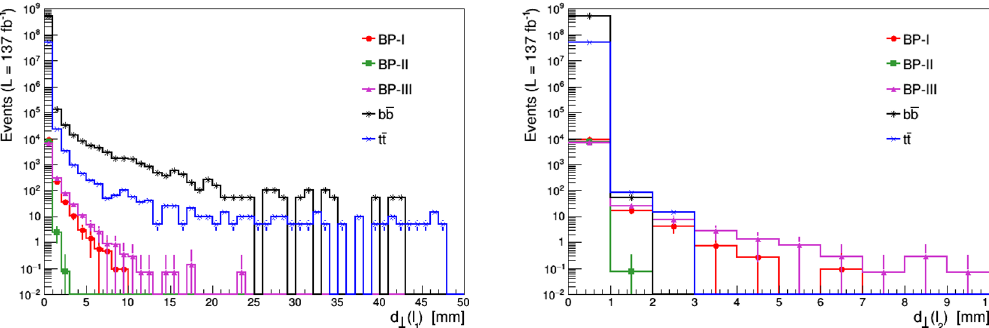
Figure 4 . Transverse impact parameter ( d ⊥ ) of leading (left) and sub-leading (right)